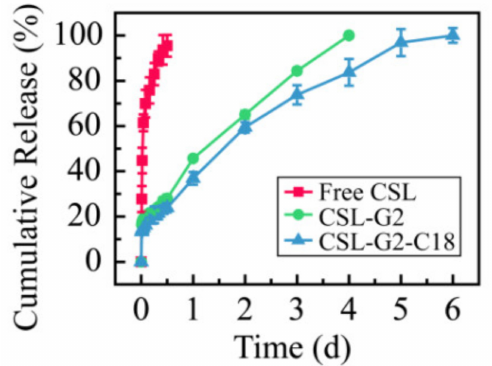
Figure 8. Cumulative release rate of CSL in 5% glucose solution at 37 ◦ C over 144 h.